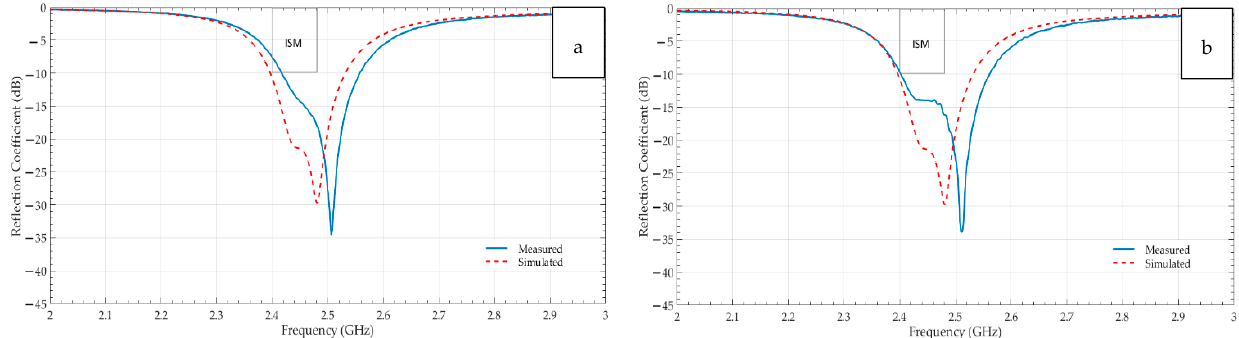
Figure 10. Simulated and measured reflection coefficients-S11 of ( a ) non-perforated KOLN based RRMPA ( b ) perforated KOLN based RRMPA.